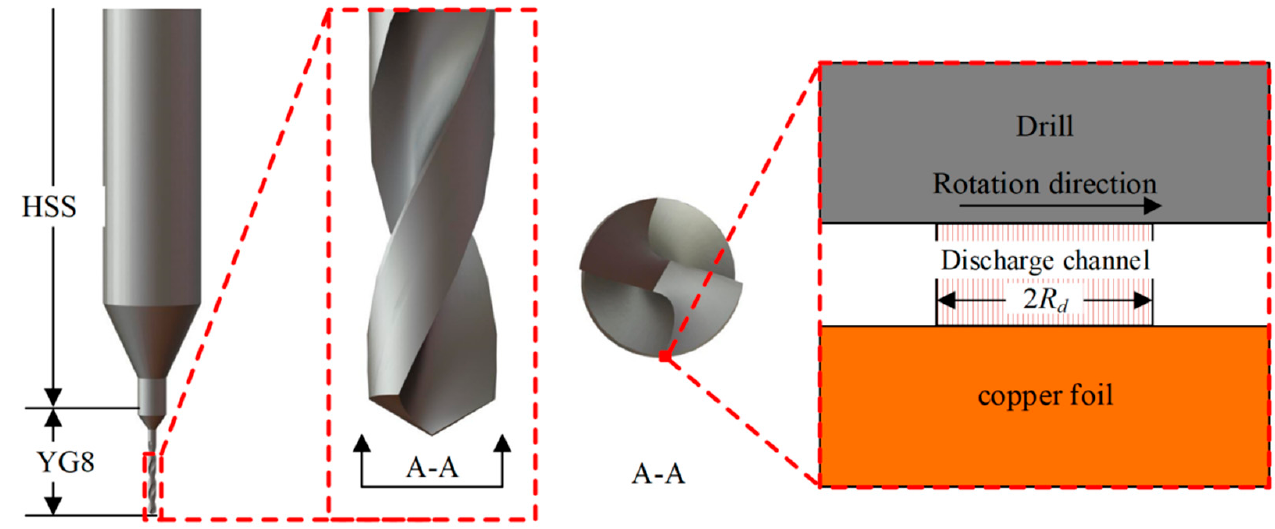
Figure 1. Discharge